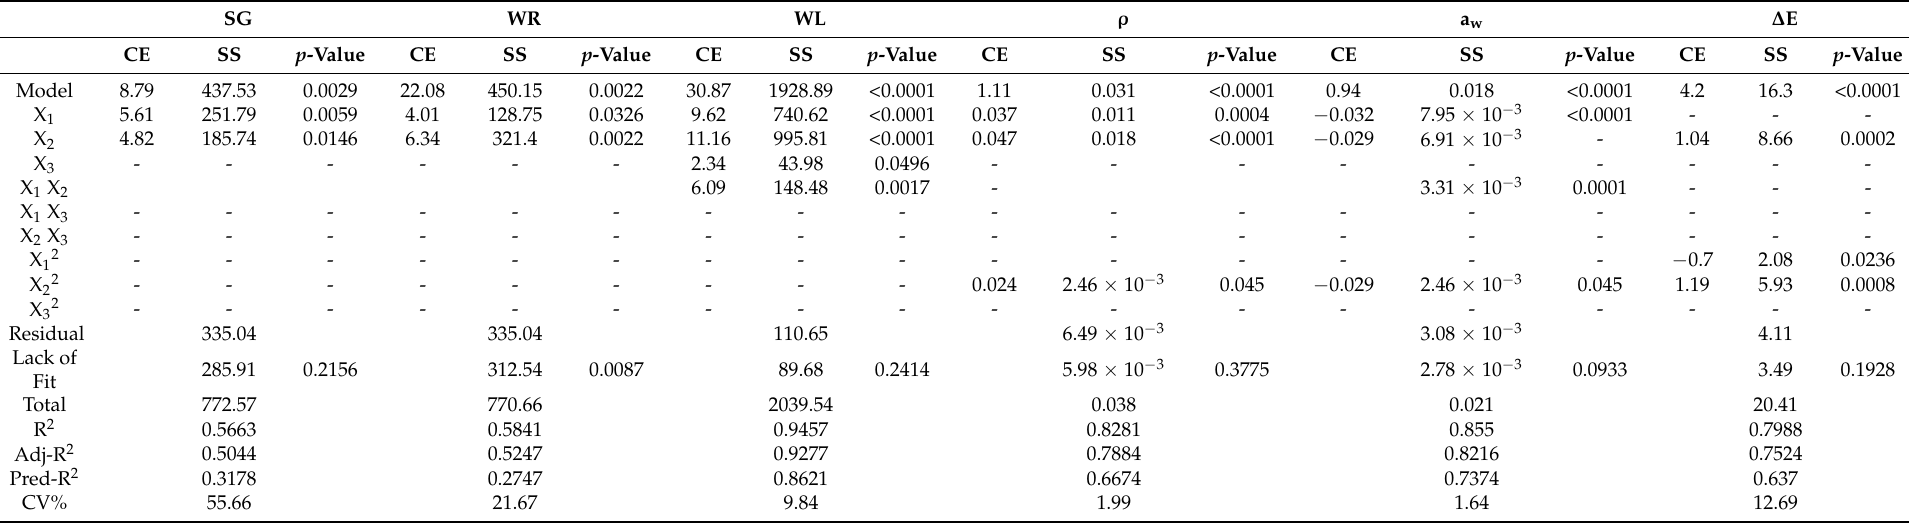
Table 3. Analysis of variance (ANOVA) for variable responses, and the coefficient predicted by quadratic reduced